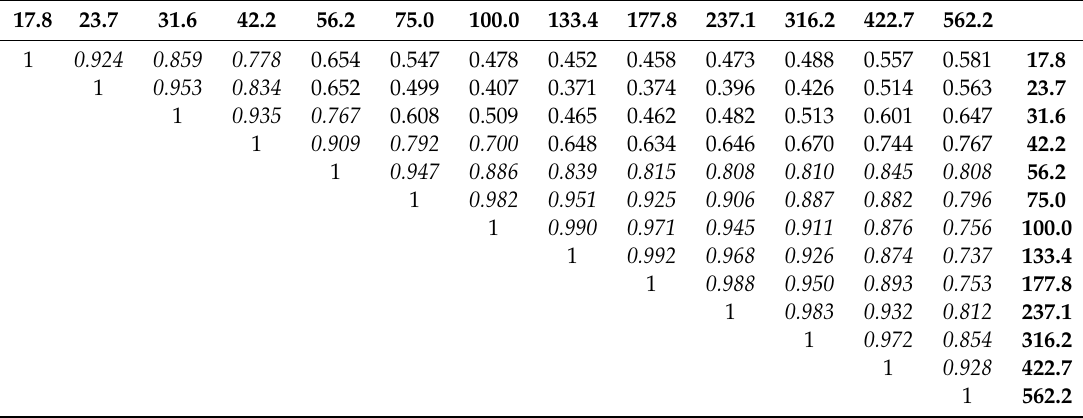
Table 2. Pearson’s correlation among channels in the range 23–750 nm. In italics , the correlations > 0.7.